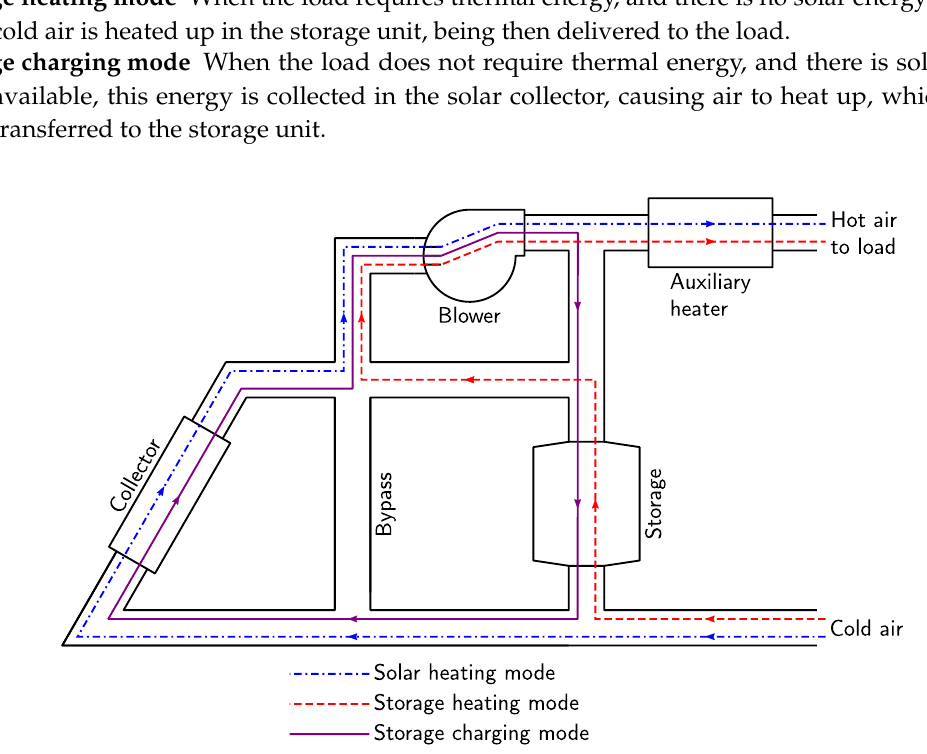
Figure 1. Main elements and working modes of a solar air